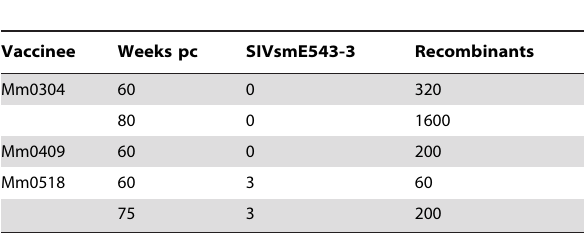
Table 2. SIVsmE543-3 derived and recombinant viruses in non-controllers a .